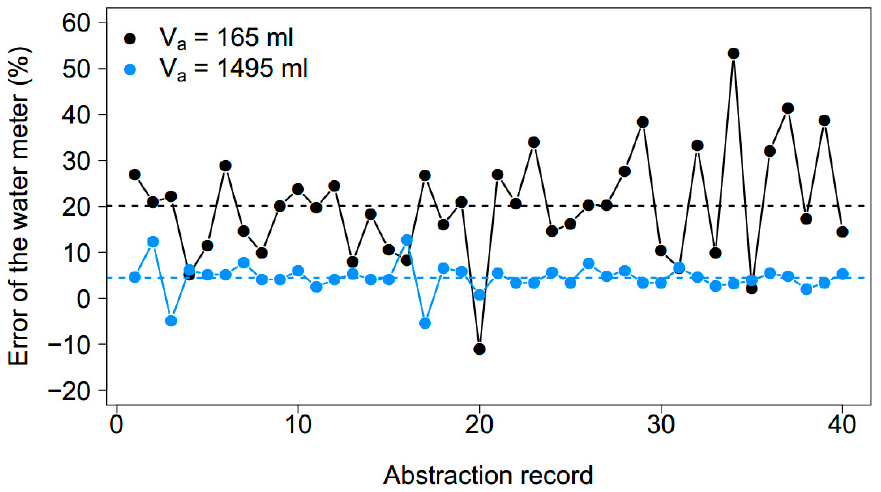
Figure 4. Behavior of the error of the water meter for 165 mL (black circles) and 1495 mL (blue circles) abstraction volumes over the course of 40 abstractions. The dashed line indicates the mean error of the 40 measurements (20.1% for 165 mL, 4.49% for 1495 mL).